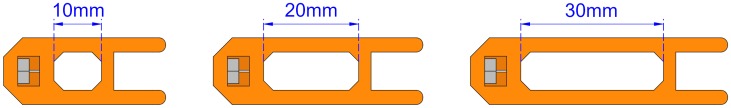
Idler tensioners with different stroke lengths.